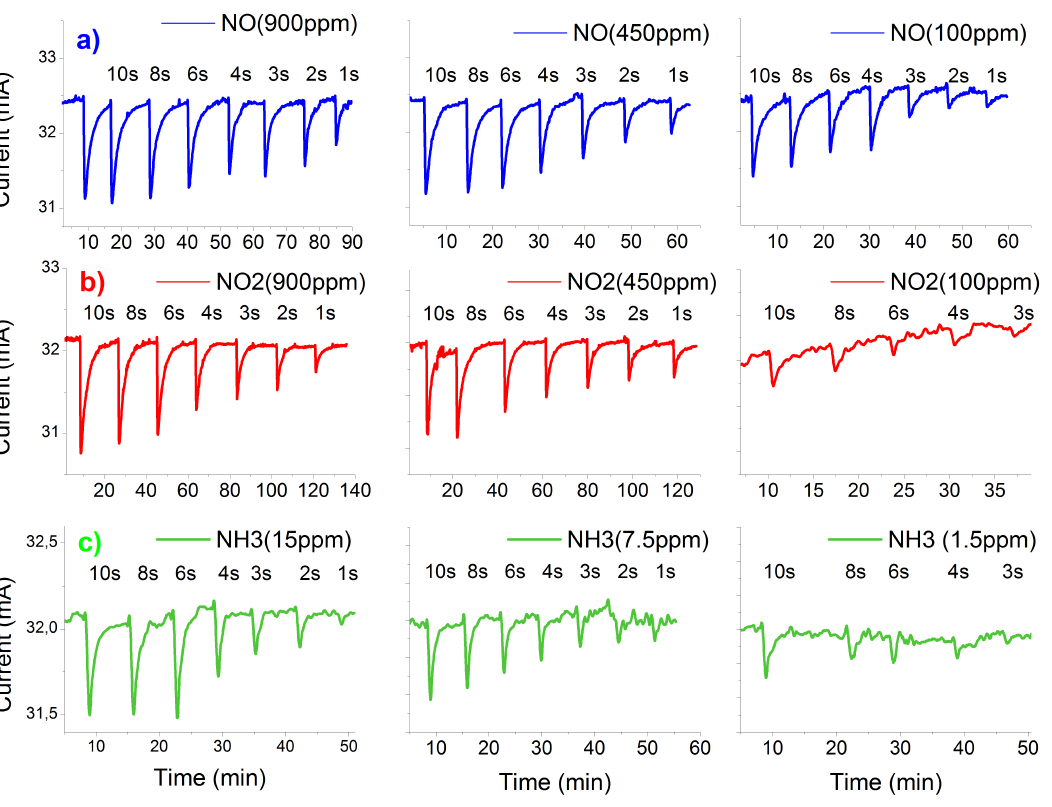
Figure 5. Sensors’ response under different exposure times for ( a ) NO; ( b ) NO 2 ; and ( c ) NH 3 gases as a function of